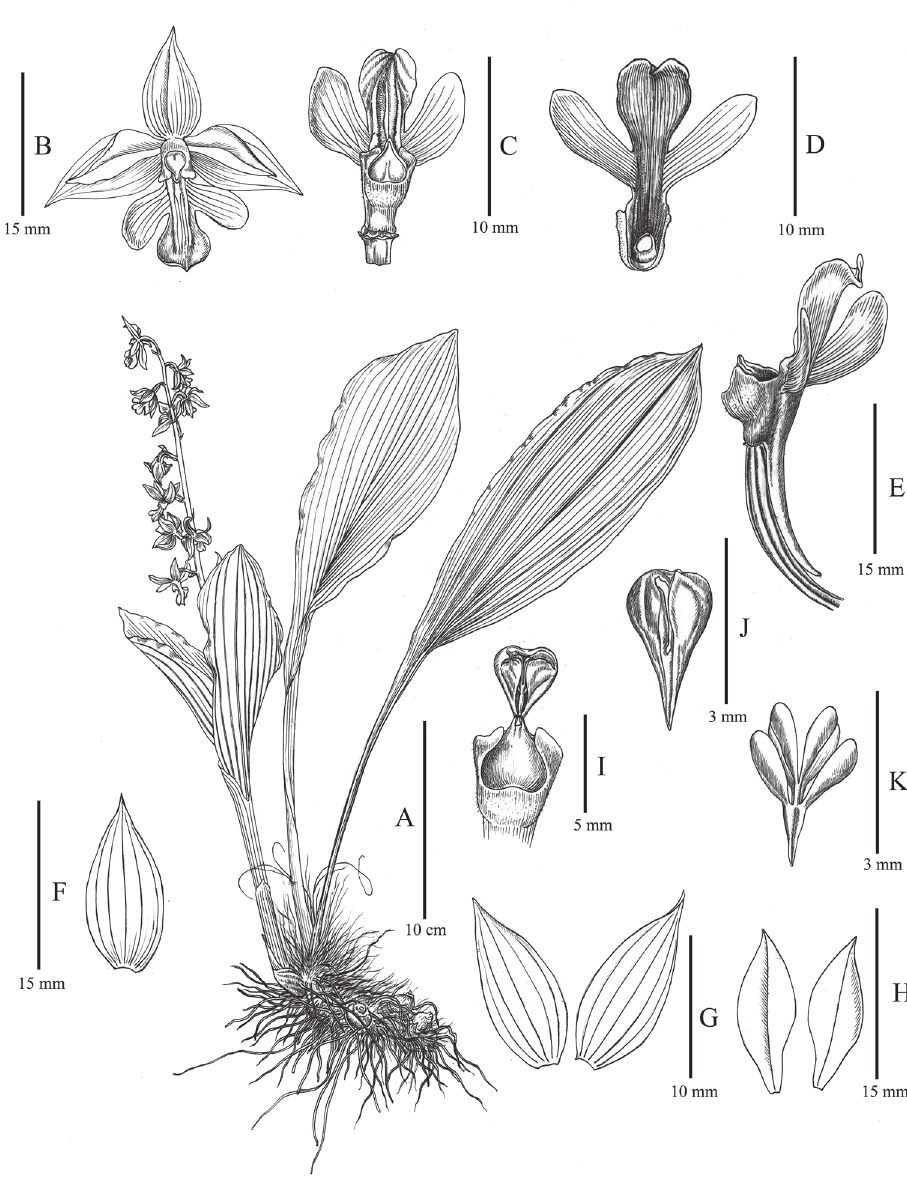
Figure 2. Line drawing illustration of Calanthe sieboldopsis B.Y.Yang & Bo Li, sp. nov. A habit B flower C column and lip (top view) D lip (bottom view) E ovary, column, lip and spur (lateral view) F dorsal sepal G lateral sepals h petals I column, rostellum and anther cap (uncovered) J anther cap (top view) K pollinia. and Taiwan provinces of China (Chen et al. 2009), but it was recently discovered from Shennongjia National Nature Reserve of Hubei Province (Xie et al. 2017) and Ji’an City of Jiangxi Province (Wang et al. 2018) (Figure 3). Calanthe sieboldopsis is